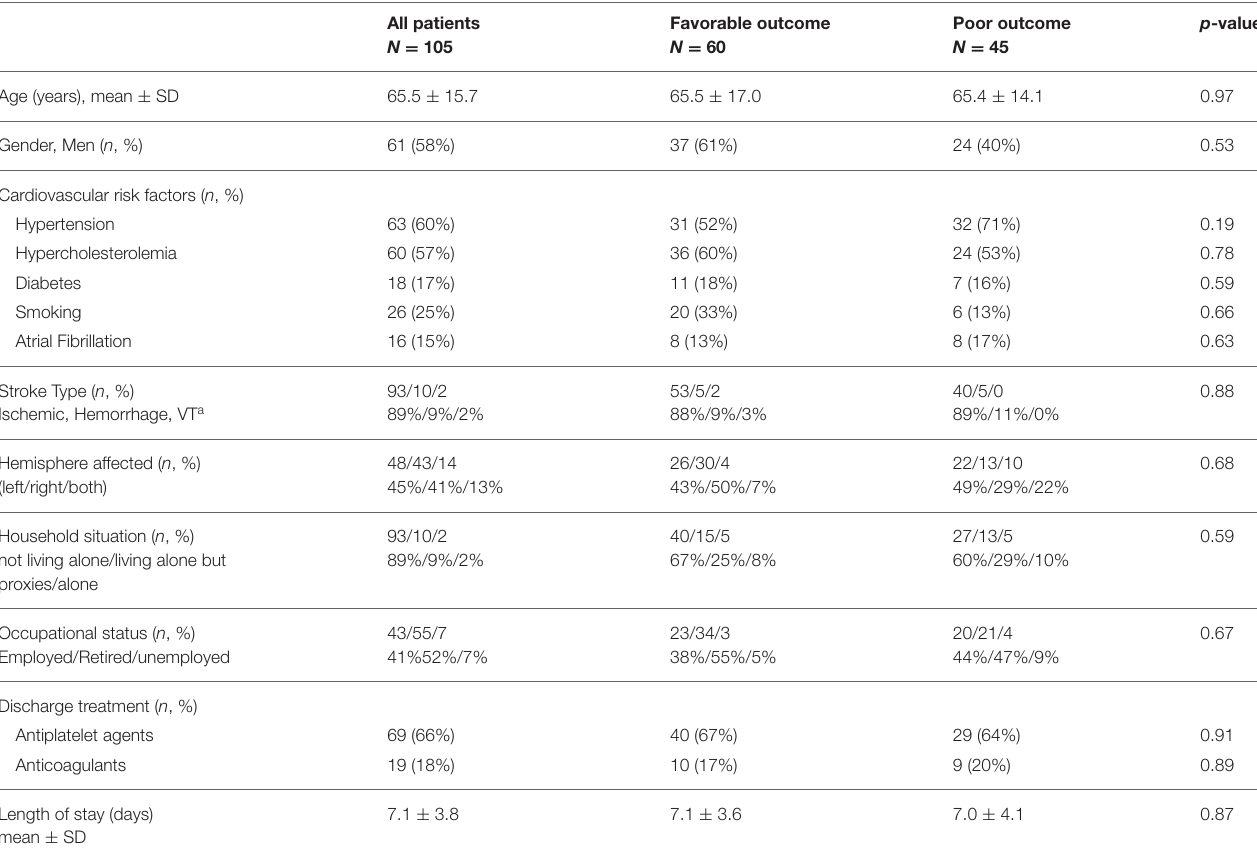
TABLE 1 | Baseline characteristics of the construction cohort.